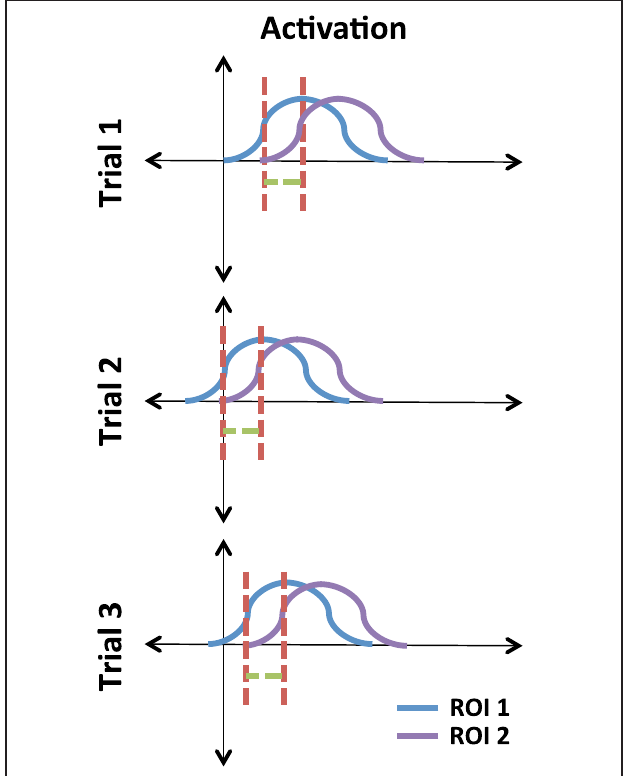
FIGURE 3 | Illustrative example of phase-locked signals. The red line is a reference relative to the peak of the signals. The green line illustrates a consistent lag between ROI 1 and ROI 2 across